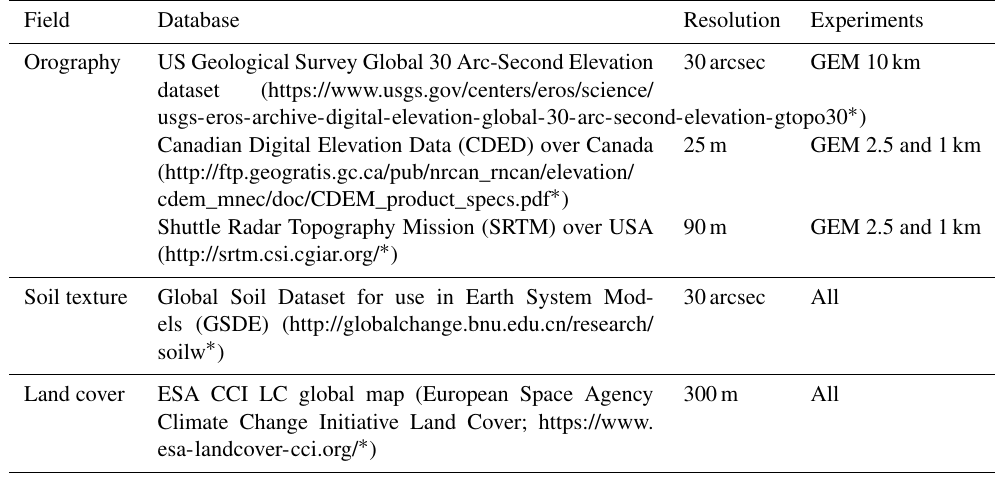
Table 3. Geophysical databases used to generate surface fields for the GEM experiments at different